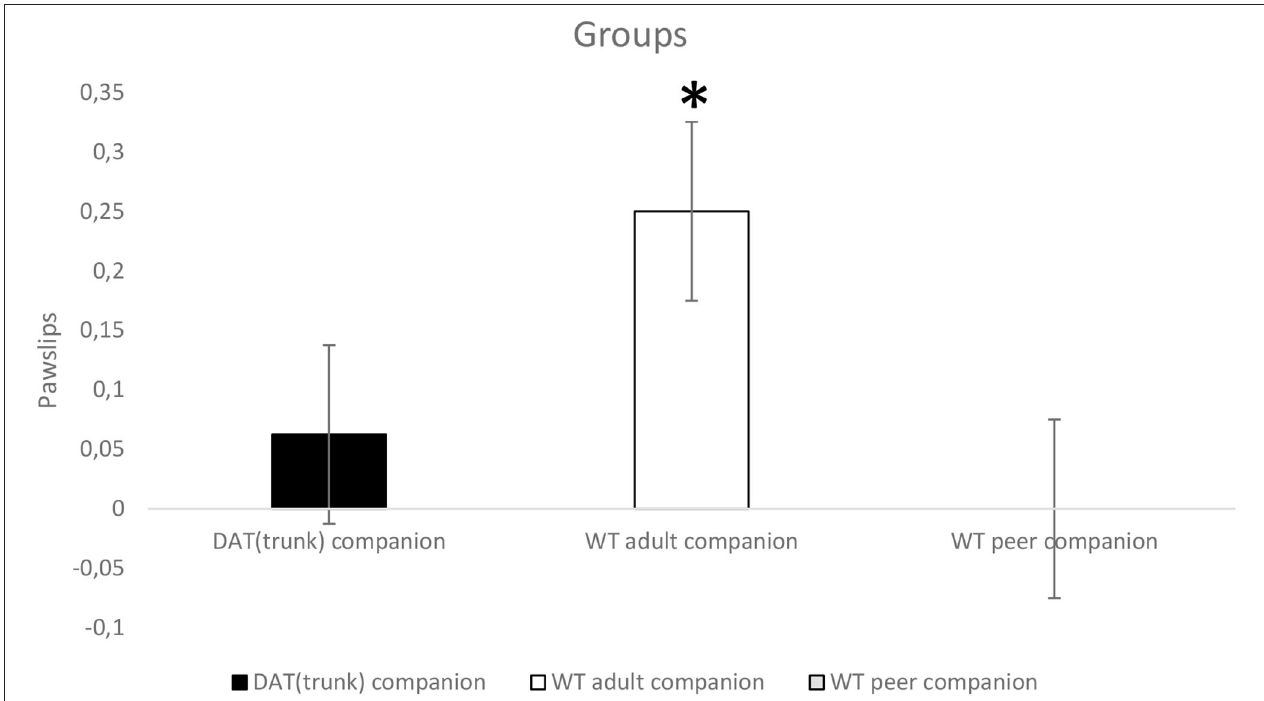
FIGURE 3 | Wild-type (WT) rats grown up with adult WT rats (white) ( n = 8) slip significantly more (* p < 0.05) than WT adolescent rats grown up with WT adolescent rats (gray) ( n = 8) when they faced up both the 99-cm stable bridge and the 99-cm unstable